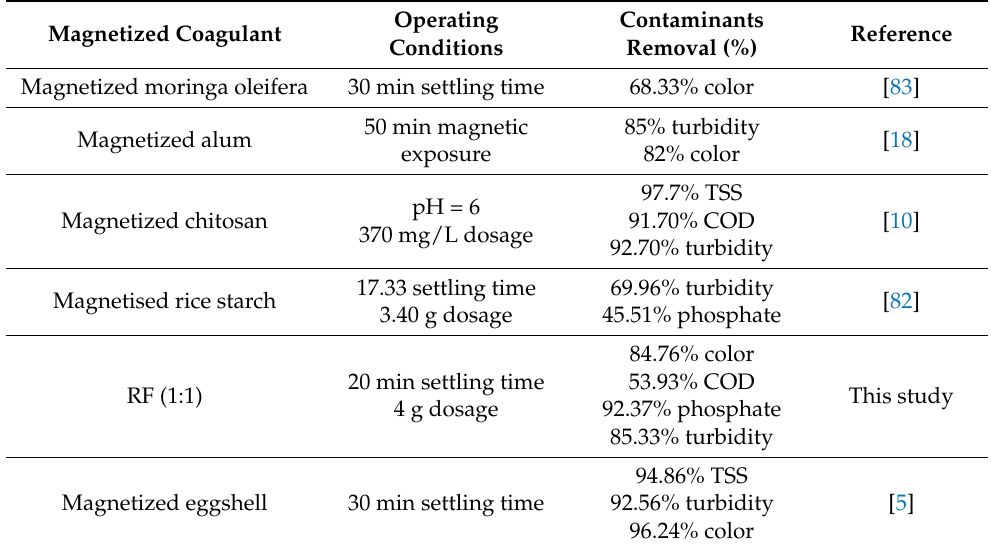
Operating Contaminants Reference Conditions Removal (%)